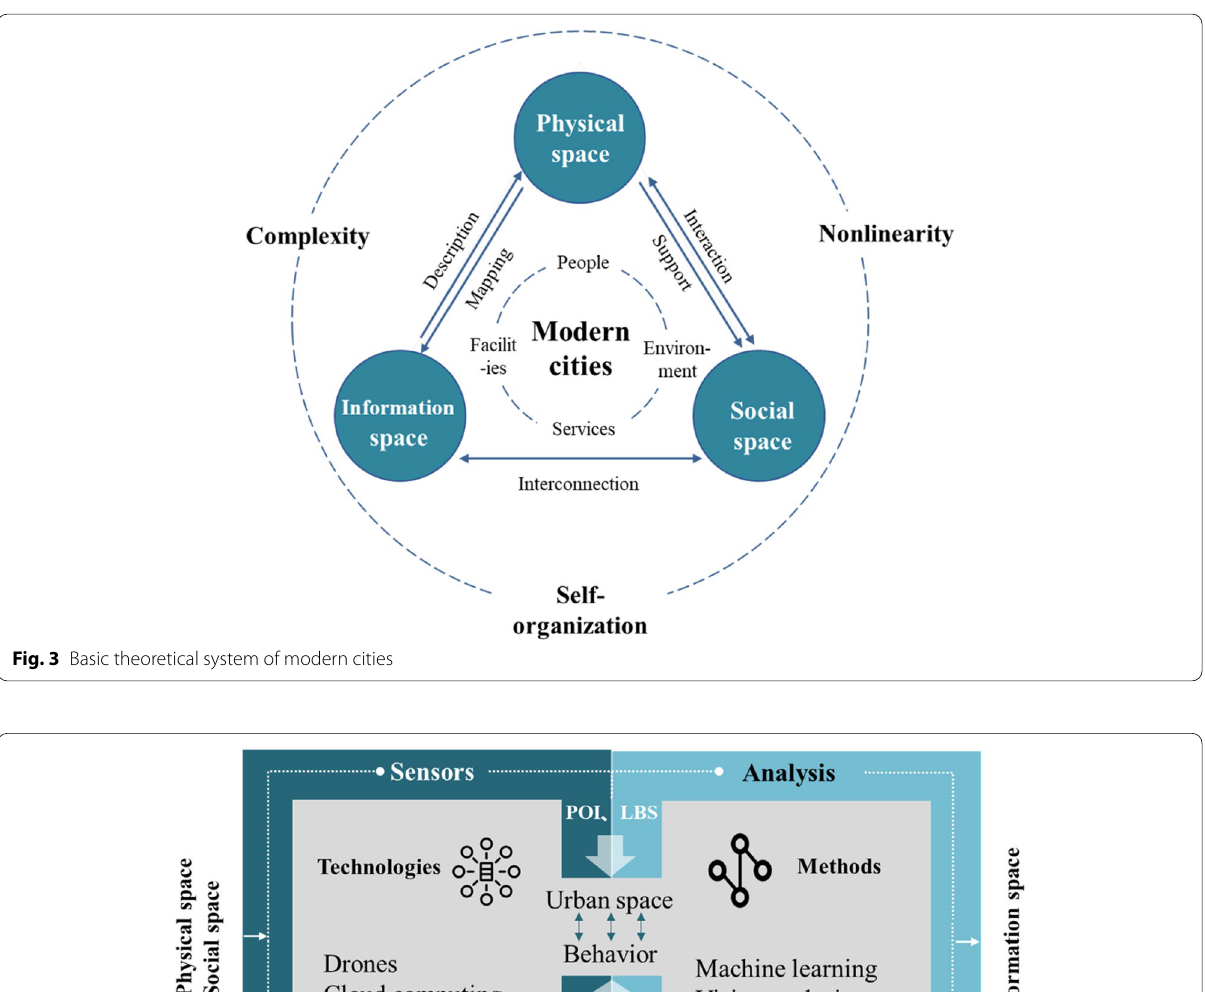
Fig. 4 Methodological support system for modern